Question: In one sentence, what is this figure communicating?
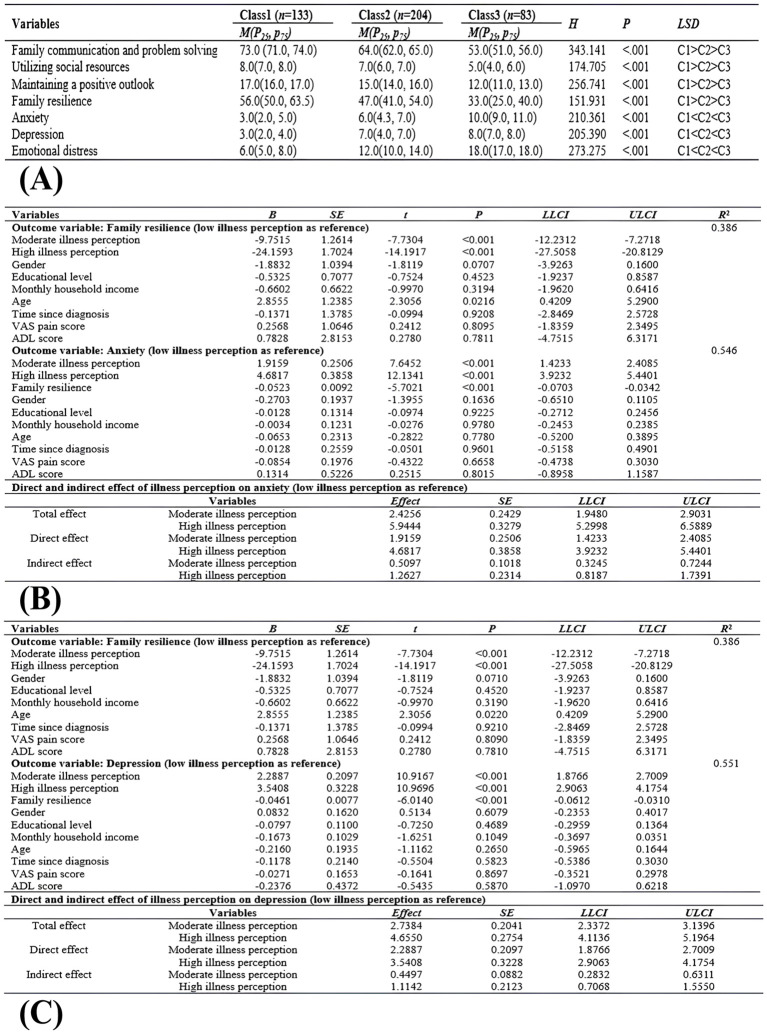
Answer: (A) Differences in family resilience and emotional distress scores across illness perception profiles. (B) The mediating role of family resilience in anxiety. (C) The mediating role of family resilience in depression.